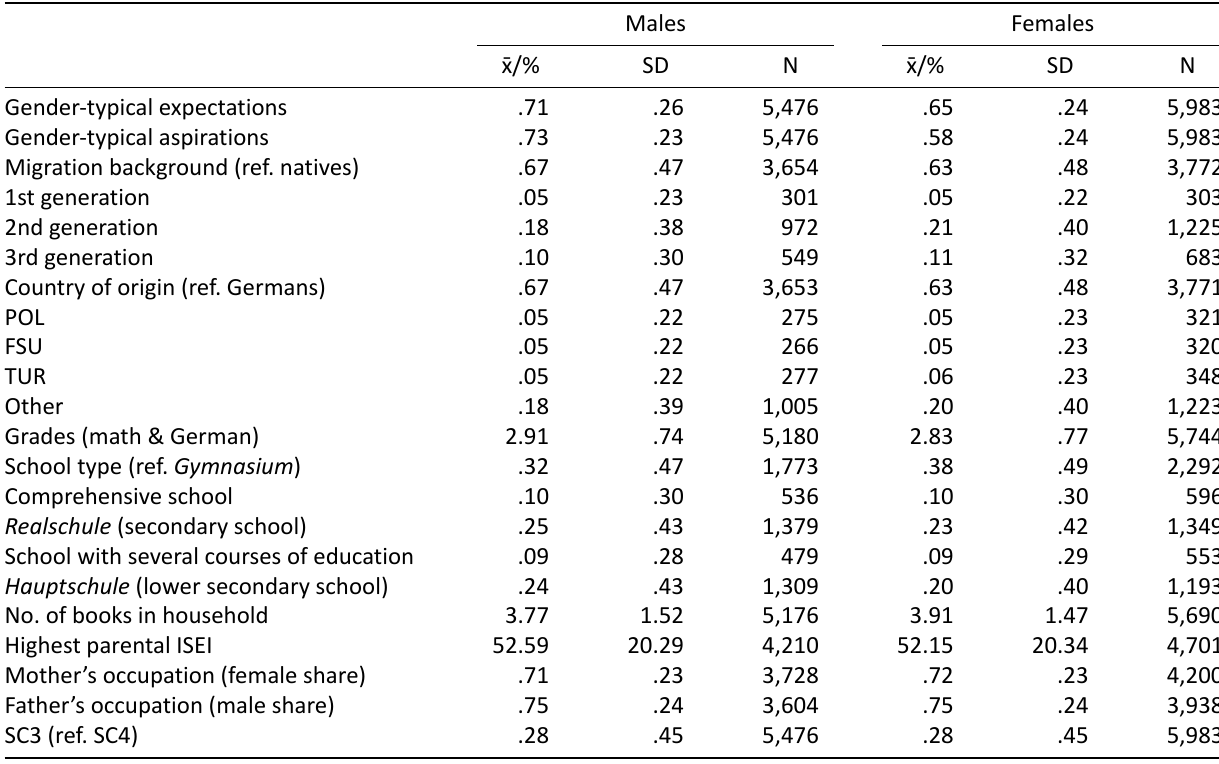
Table 2. Descriptive statistics (non‐imputed